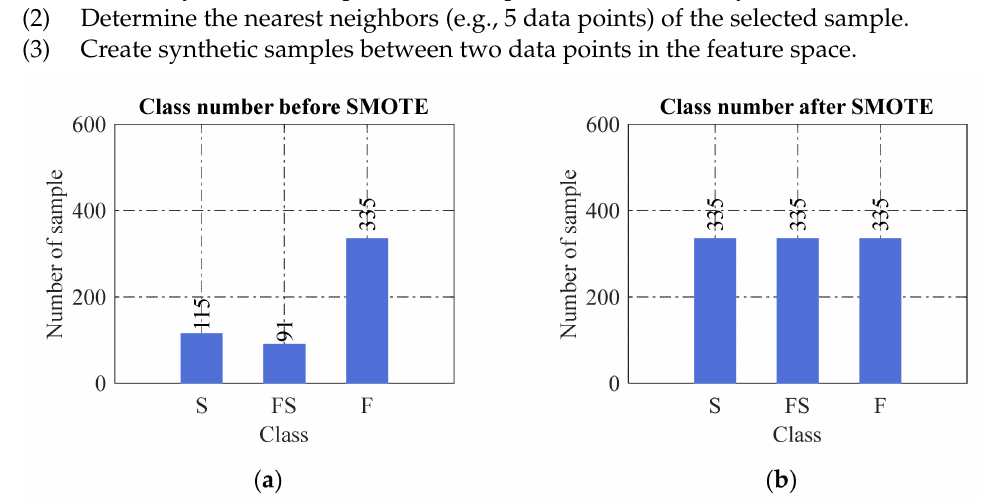
Figure 11. Distribution of failure modes in the database ( a ) before and ( b ) after performing SMOTE. To evaluate the performance of the ML techniques, typical measures consisting of accuracy, sensitivity, specificity, and area under the curve (AUC) were